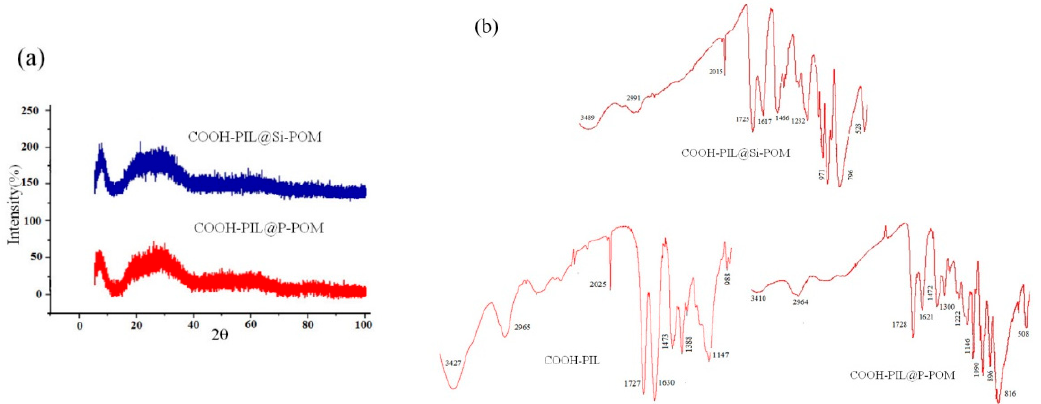
Figure 1. ( a ) XRD patterns of COOH-PIL@P-POM and COOH-PIL@Si-POM; ( b ) FT-IR spectra of COOH-PIL@P-POM, COOH-PIL@Si-POM, and COOH-PIL. COOH-PIL@P-POM, COOH-PIL@Si-POM, and